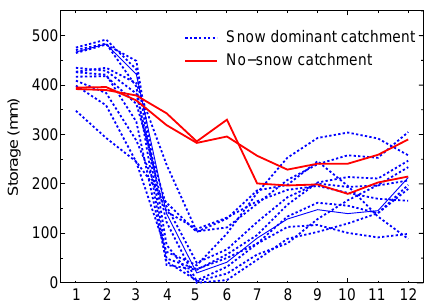
Figure A3. Seasonal water balance for raw data set.